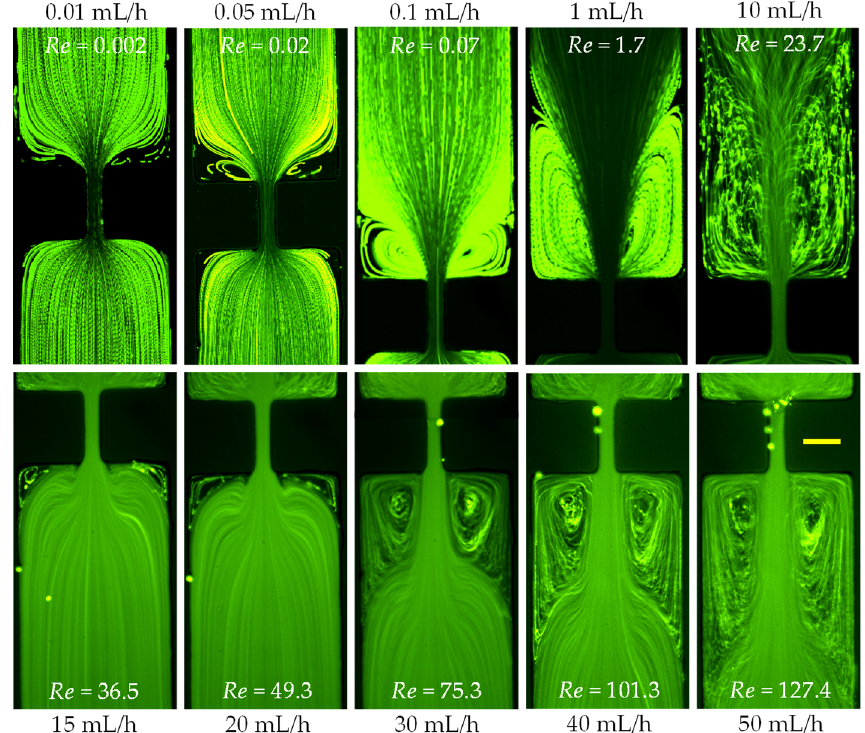
Figure 5. Inertialess ( Re < 0.1) or inertial flow (downward) of 2000 ppm shear-thinning XG solution at the contraction–expansion region of the microchannel. The scale bar represents 100 µm.